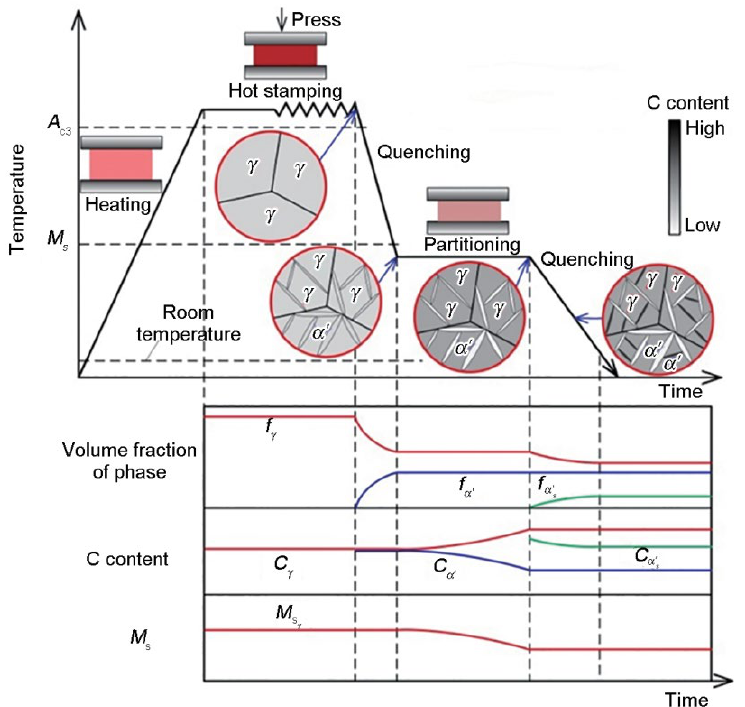
Figure 6. Schematics of hot stamping, quenching and partitioning (HS-Q&P) process, and microstructural evolution [15]. Reprinted with permission from [15]. Copyright 2022 CSPM.